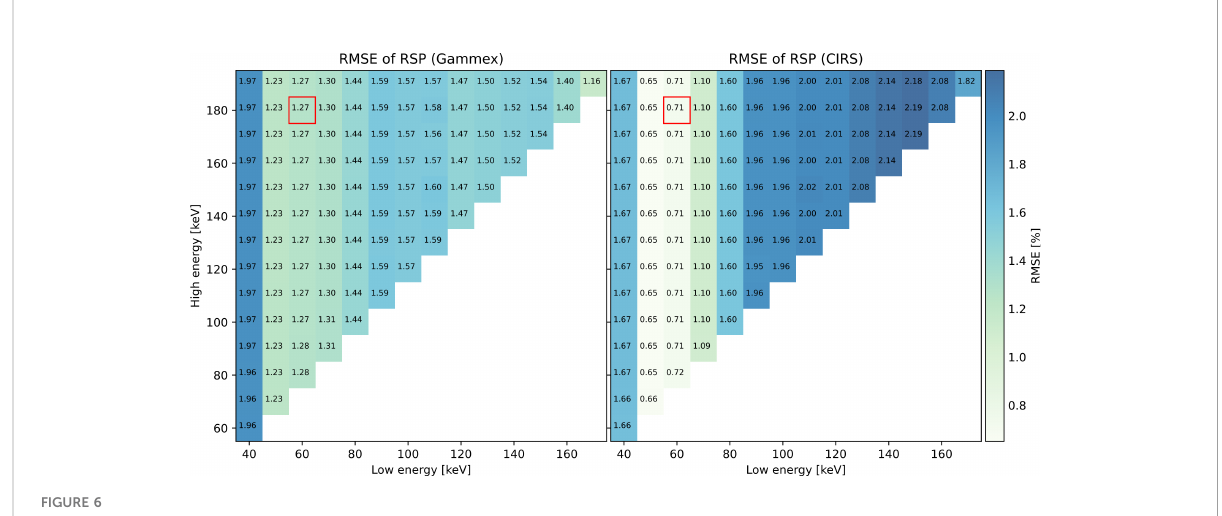
FIGURE 6 RMSEs of RSP for all the monoenergy